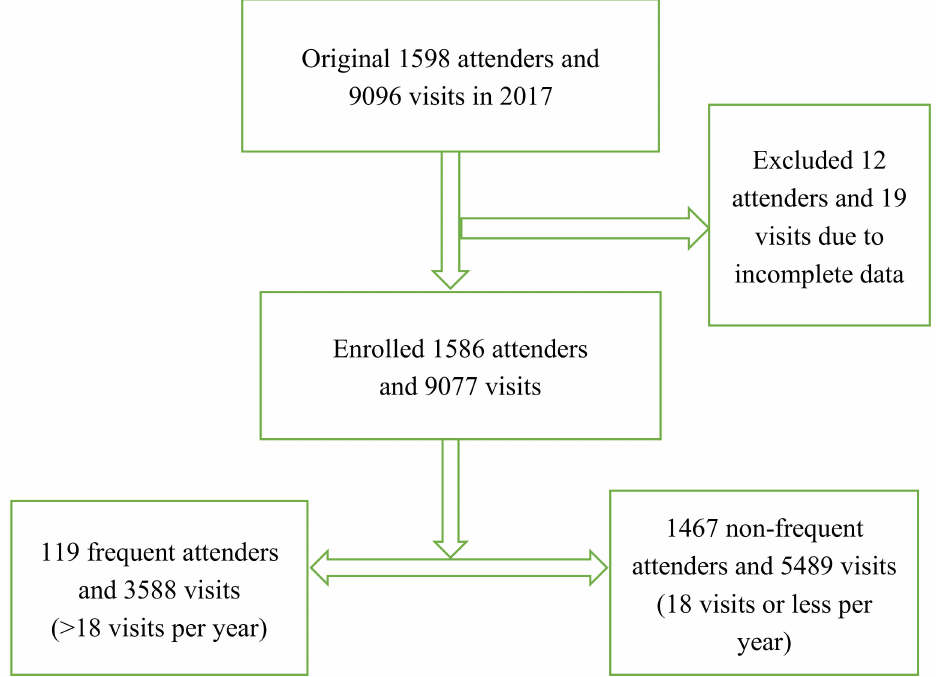
Figure 1. The design of the